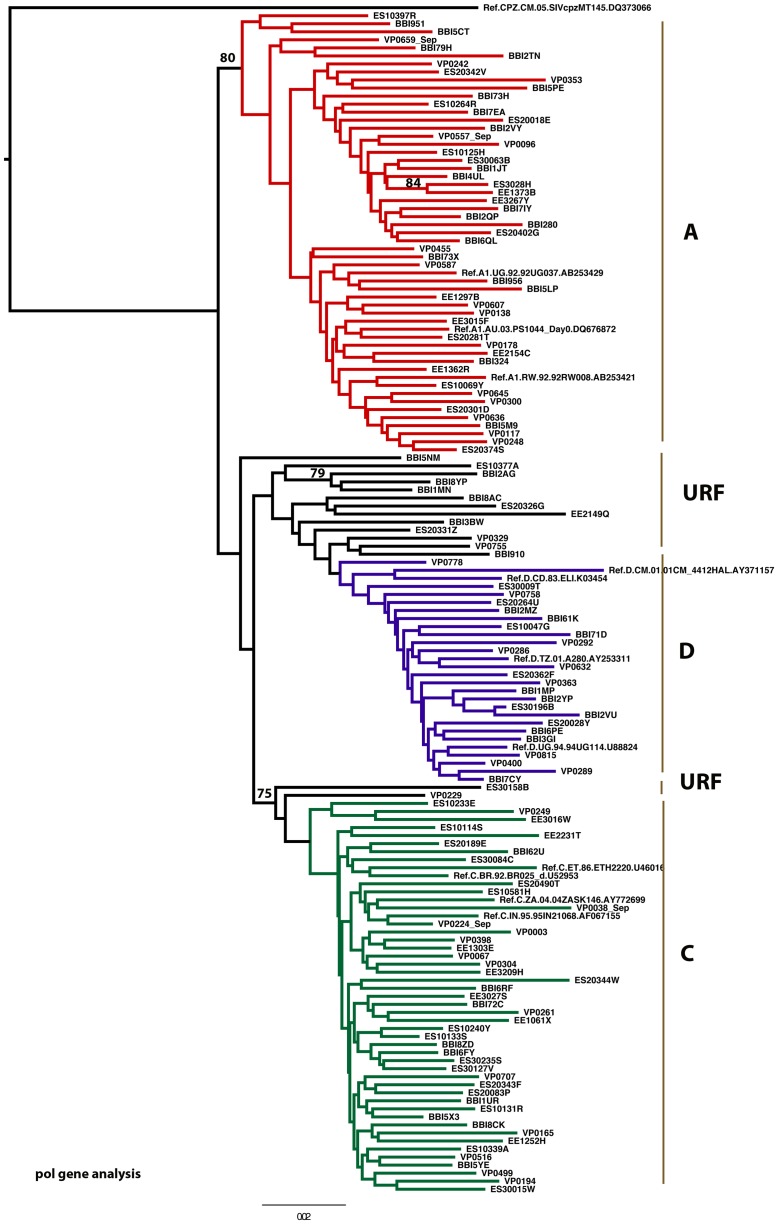
pol gene analysis tree.Results are presented for the 136 sequences which passed for phylogenetic analysis.